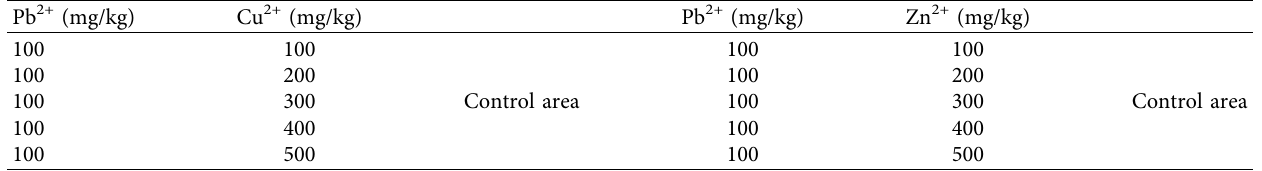
Table 1: Field experiments to investigate the effect of copper and zinc on the accumulation of lead from soil of plants.